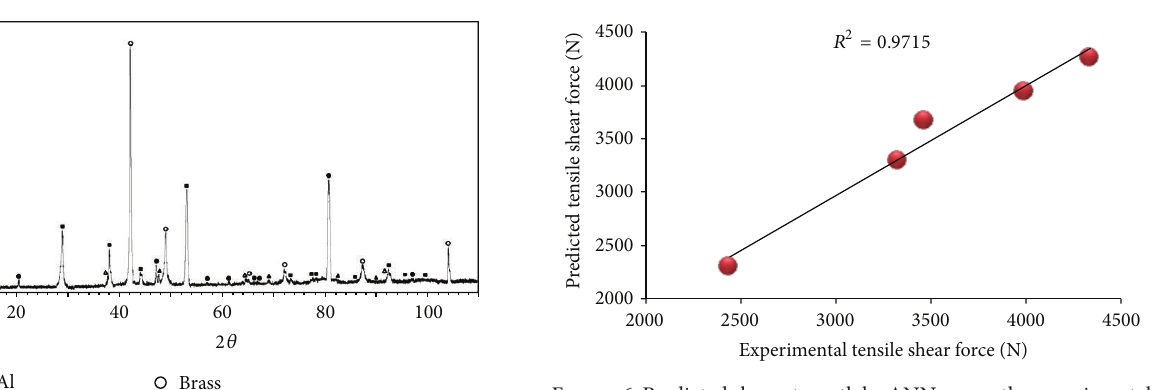
Figure 6: Predicted shear strength by ANN versus the experimental data and theregression lineat the testing stage for tensile shear